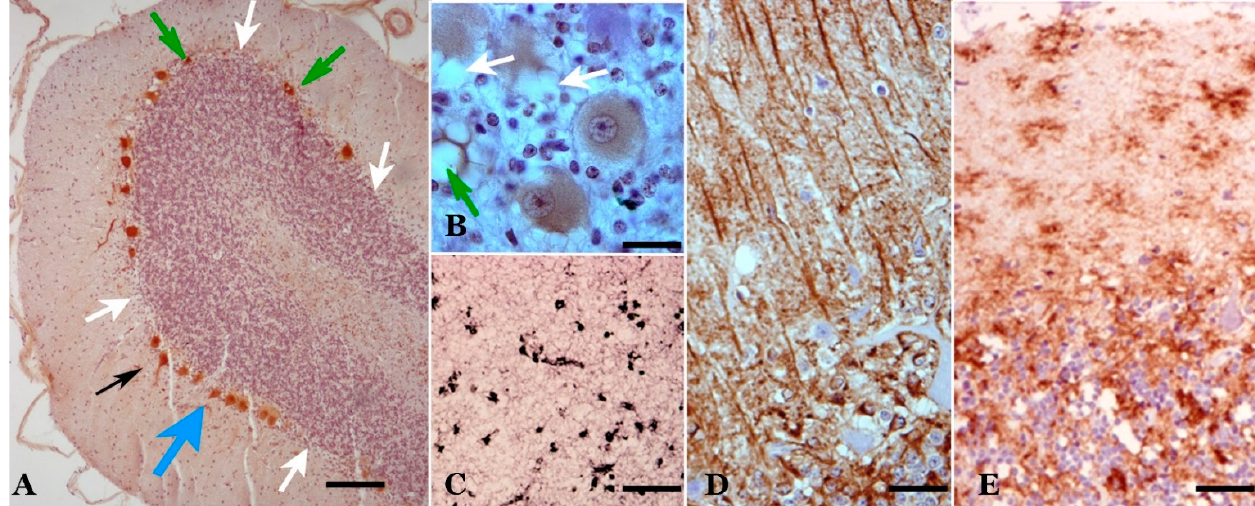
Figure 1. Main neuropathological alterations in classical scrapie. ( A ) Neuronal changes and loss. In these cerebellar folia, Purkinje neurons of different morphologies are observed: normal, hypertrophic (black arrow), atrophic (green arrows) and dystrophic (blue arrow). Likewise, areas exist where neurons have been lost (white arrows). Calbindin immunostaining plus hematoxylin contrast. ( B ) “Spongiform” (vacuolar) structures. Vesicles of different types are seen both in the neuropil (green arrow) and in the cytoplasm of neurons (white arrows). Calbindin immunostaining plus hematoxylin contrast. ( C , D ) Neuroglial reactivity. In ( C ), microgliosis is shown (proliferation of different types of microglia—rounded or branched). LN3 immunostaining plus Ni contrast. In ( D ), astrogliosis (hypertrophy, hyperplasia and increased number of gliofibrils) is shown. GFAP immunostaining plus hematoxylin contrast. ( D ) Abnormal prion protein (PrP) deposits/deposition. Various types of accumulations in the neuropil associated with cells, both in the form of dispersed or coalescent granulations and in a star-like shape. Abnormal PrP immunostaining plus hematoxylin contrast. ( E ) Abnormal PrP immunostaining plus hematoxylin contrast. (Bar: A = 125 µ m; B = 20 µ m; C = 125 µ m; D = 30 µ m; E = 35 µ m).